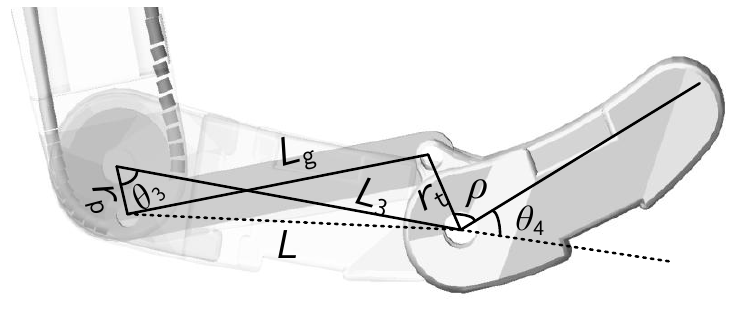
Figure 8. The coupled structure of the three-DOF